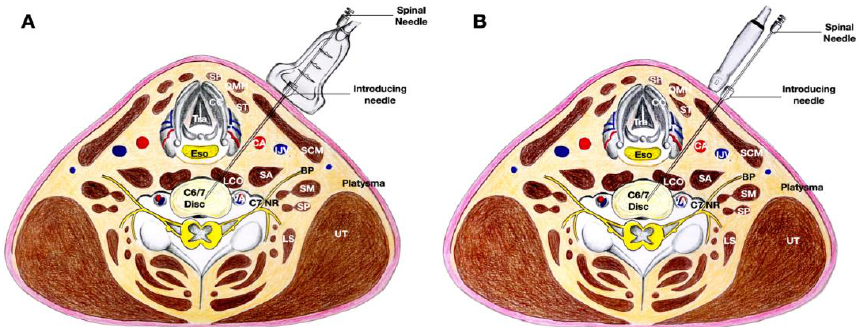
Figure 3. The figure shows the cross-sectional anatomy and the biplanar approach of ultrasound- guided needle placement into the C6/7 intervertebral disc with the trajectory of the needle between the thyroid gland and carotid artery. ( A ) The transducer is in the transverse plane of the neck so an out-of-plane technique is used. ( B ) The transducer is in the sagittal plane of the neck and an out-of-